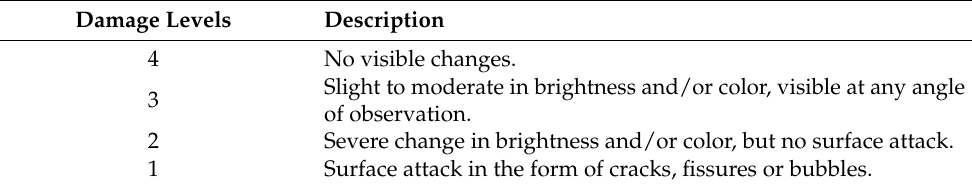
Table 1. Visual assessment of cladding surface damage. NBR 15575-3, 2013 [10]. Damage